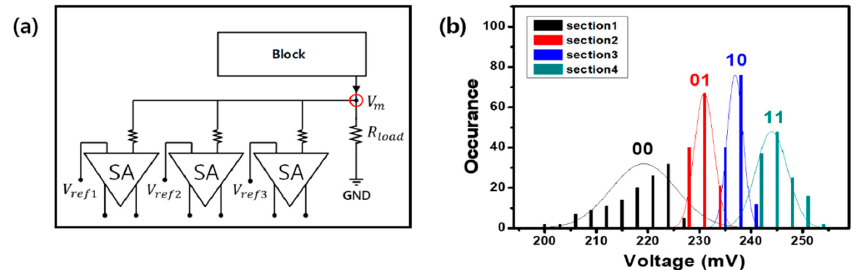
Figure 5. ( a ) Sense amplifier block circuitry, where each block has the same circuitry; and ( b ) voltage distribution quantized into four sections. The voltage indicates the red marked node V m in ( a ) and each section is allocated to a two-bit response (00, 01, 10, or 11).